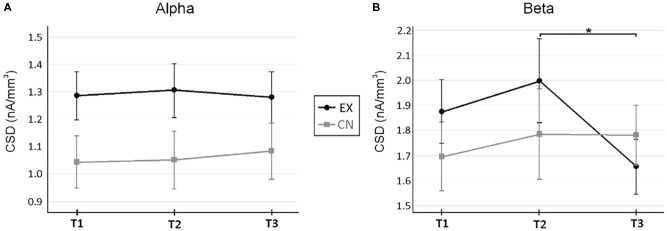
Current source density changes in the anterior cingulate cortex (ACC) across rest and virtual reality intervals. (A) Changes in Alpha across measurement time points. (B) Changes in Beta activity across measurement time points. A significant interaction (p < 0.05) occurred for ACC Beta activity. ∗Denotes p < 0.05 for follow up within-subject repeated measure ANOVAs by group, corrected for multiple pairwise comparisons. ∗Denotes p < 0.05, for within-subject repeated measure ANOVA, after correction for multiple pairwise comparisons. Current source densities were estimated with sLORETA (Pascual-Marqui, 2002).